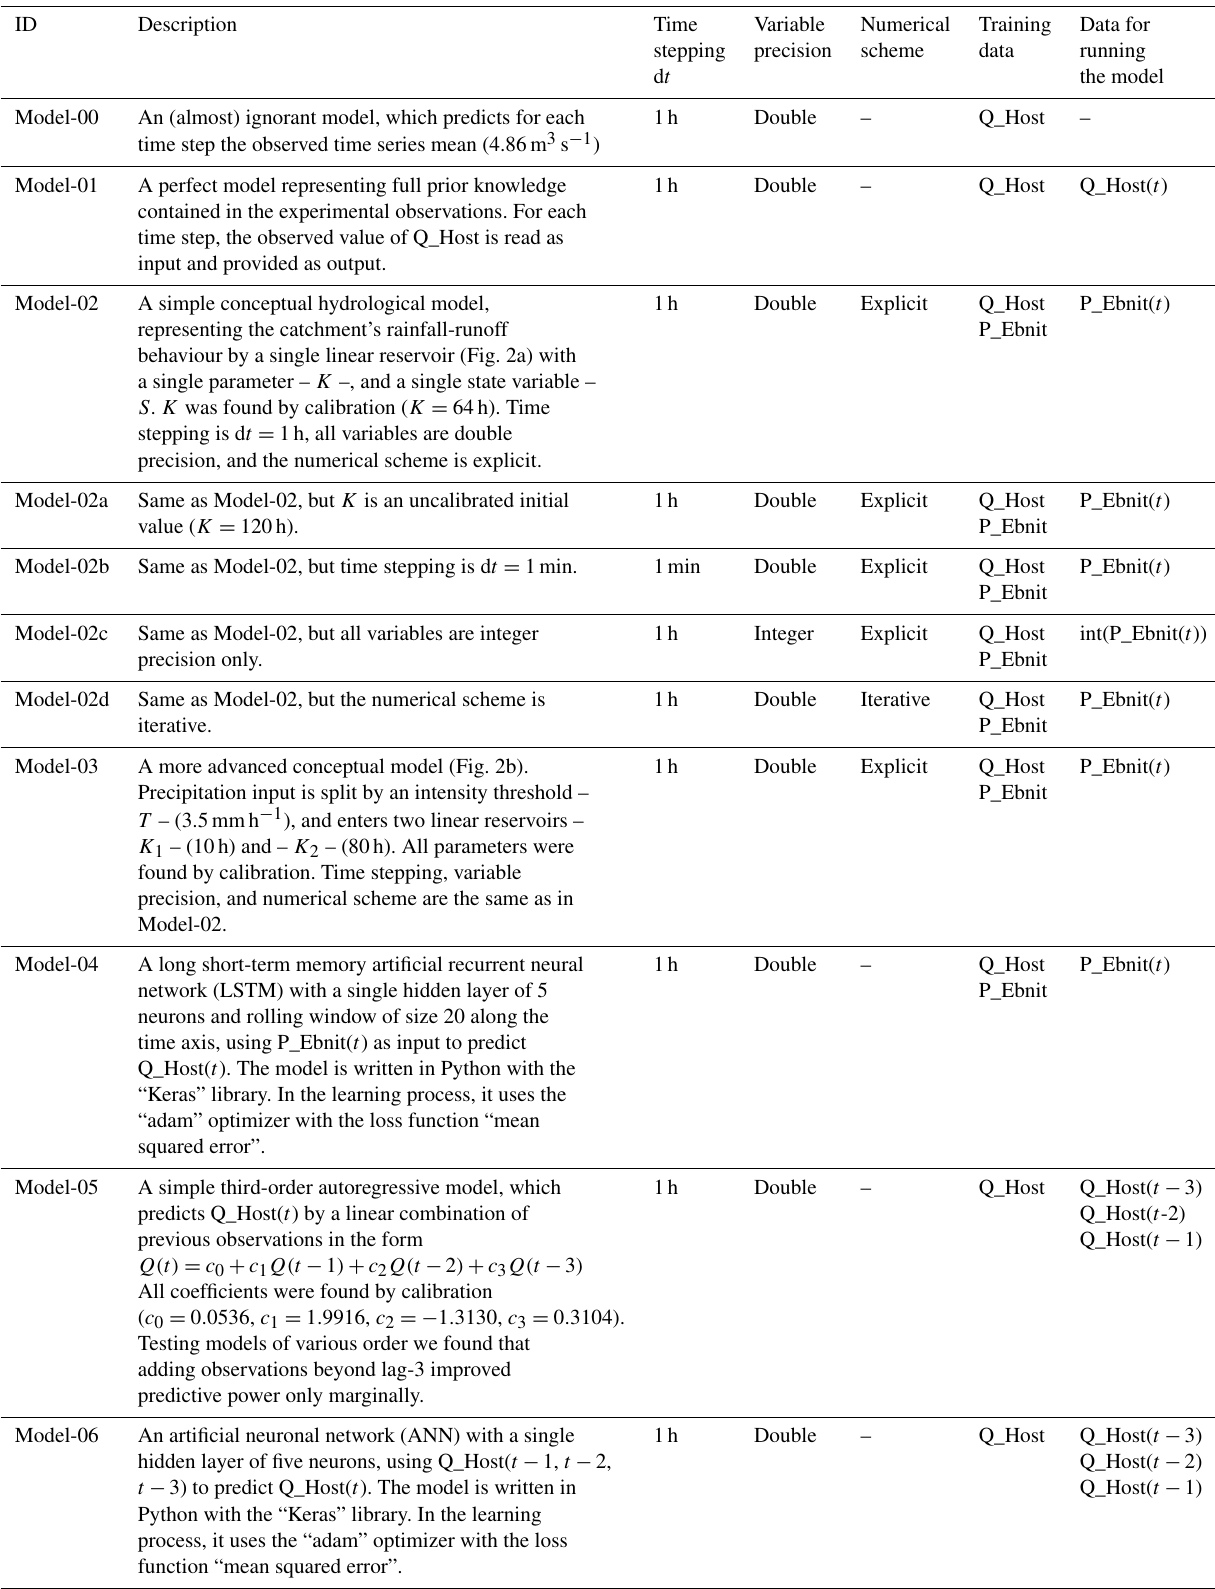
Table 1. Models used in the study and their characteristics. ID